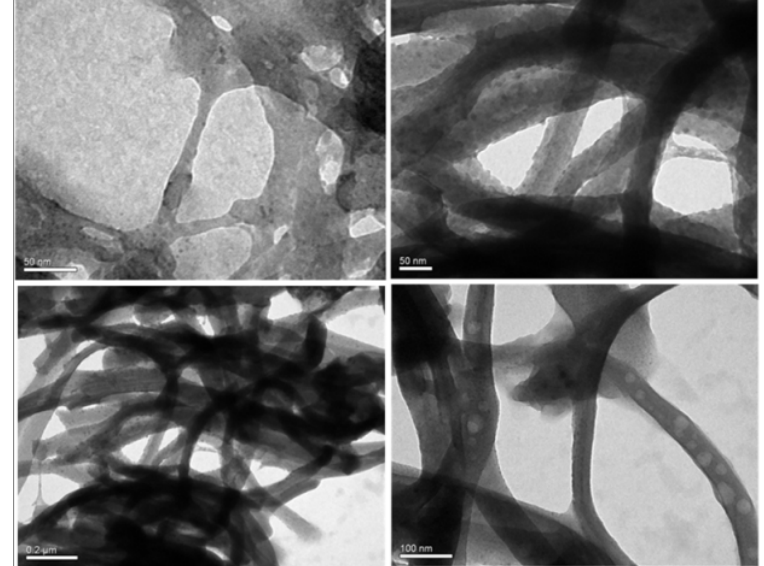
Figure 13. C-S-H/PMA (a, b) TEM